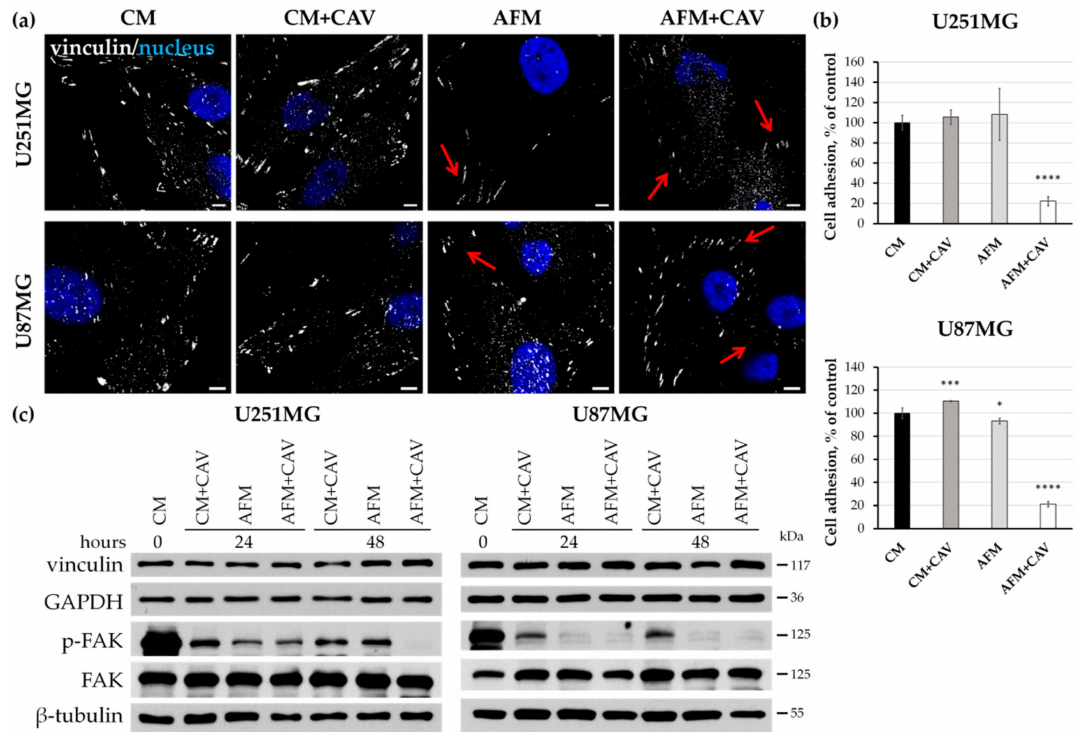
Figure 7. E ff ects of canavanine on adhesion of human glioblastoma cells. ( a ) Immunocytochemical staining for vinculin. Nuclei were labeled with DAPI. Cells were treated for 48 h under indicated experimental conditions under CM and AFM, with or without 50 µ M canavanine. Bars, 10 µ m. Arrows point to altered focal adhesion contacts. ( b ) Cancer cell adhesion to collagen I after the 48 h of treatment in CM and AFM with or without CAV. Graphs represent mean values ± SD from three independent experiments. * p < 0.05, *** p < 0.001, **** p < 0.0001 relative to CM (control, 100%). ( c ) Immunoblotting of proteins involved in cell adhesion and migration. GAPDH and β -tubulin were used as protein loading